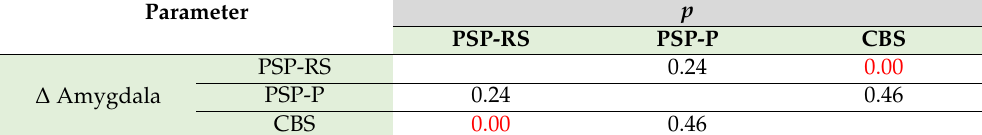
Table 3. Post hoc analysis.